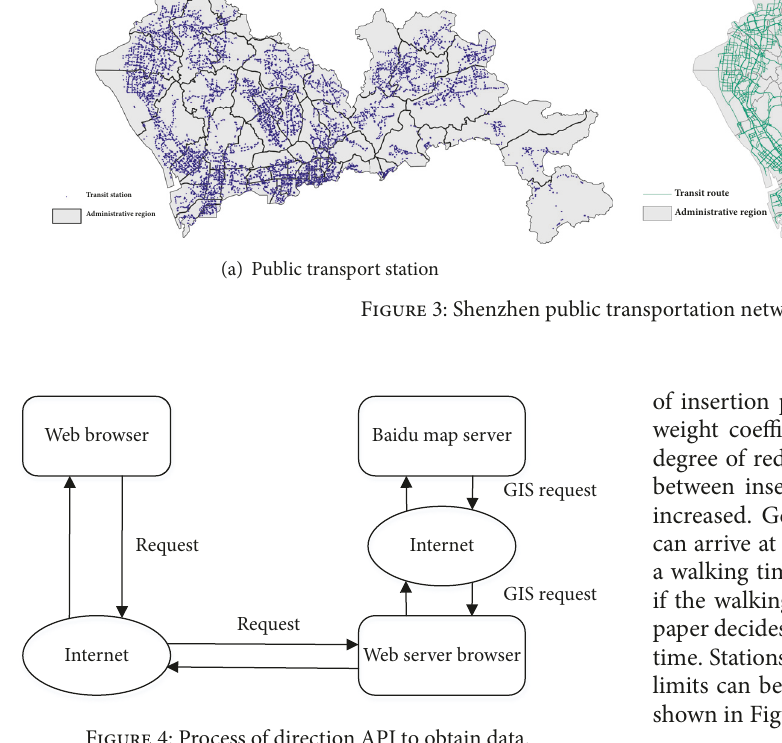
Figure 4: Process of direction API to obtain